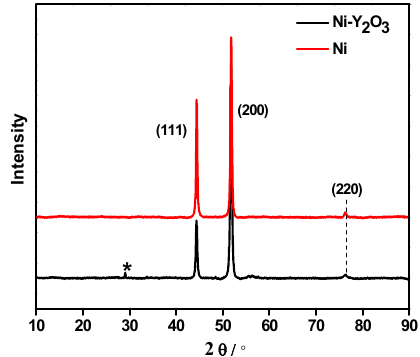
Figure 9. XRD patterns of nickel and composite.